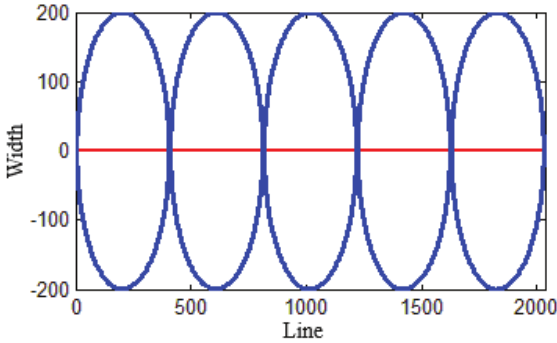
Figure 13: Case 1: The optimal line tunnel (L = 2034)